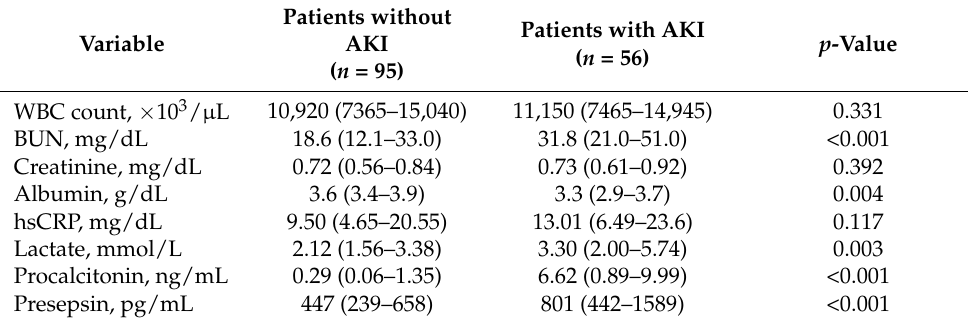
Table 2. Comparison of laboratory results on ED admission between patients with COVID-19 with AKI and those without AKI.